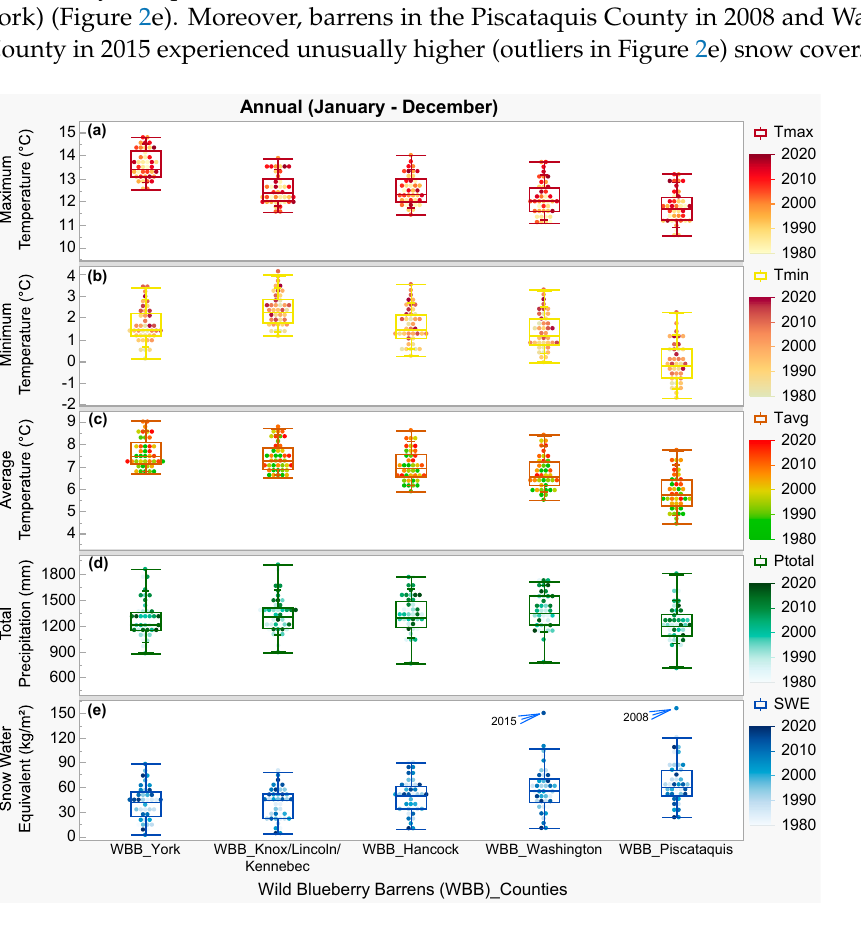
Figure 2. Comparison of historical (1980 to 2020) annual climate parameters: ( a ) maximum temperature, ( b ) minimum temperature, ( c ) average temperature, ( d ) total precipitation, and ( e ) snow water equivalent among the studied wild blueberry barrens (WBBs) in different counties from north-central (Piscataquis) and north-east (Washington, Hancock) to south-west (Knox, Lincoln, Kennebec, York) of Maine as shown in Figure 1. The annual maximum temperature increased significantly in the wild blueberry barrens in Piscataquis (1 °C) and Washington (1.3 °C) Counties, compared to other studied coastal counties farther south-west (Hancock to York), where temperature increment rates (0.2–0.6 °C) were not significant (Figure 3a, Table 1). In contrast, the annual minimum temperature significantly increased (1.2–1.7 °C) in the barrens of all studied counties (Figure 3b, Table 1). Consequently, the annual average temperature (Figure 3c, Table 1) increased significantly (0.8–1.5 °C) in the barrens of all studied counties but the increase rate was higher in Piscataquis and Washington counties (1.3–1.5 °C) compared to other coastal counties (0.8–1 °C) farther south-west. Moreover, the annual total precipitation increased in the barrens of all studied counties, but the increase was significant at a rate of 5.61 mm/yr (~0.22”/yr) only in Washington County (Figure 3d, Table 1). The precipitation increase rate was significantly slower in Piscataquis County (2.93 mm/yr: 0.11”/yr) compared to the increase rate in other studied counties (4.4–5.6 mm: 0.17– 0.22”/yr) (Table 1). There were no significant changes in historical snow cover trends (Figures 3e and S3, Table 1). The increasing trend in snow cover (15 kg/m 2 ) in the counties from Knox to York (Figures 1 and S1), and the decreasing trend in snow cover (15 kg/m 2 ) in Piscataquis County (Figure 3e) from 1980–2020 were not significant.